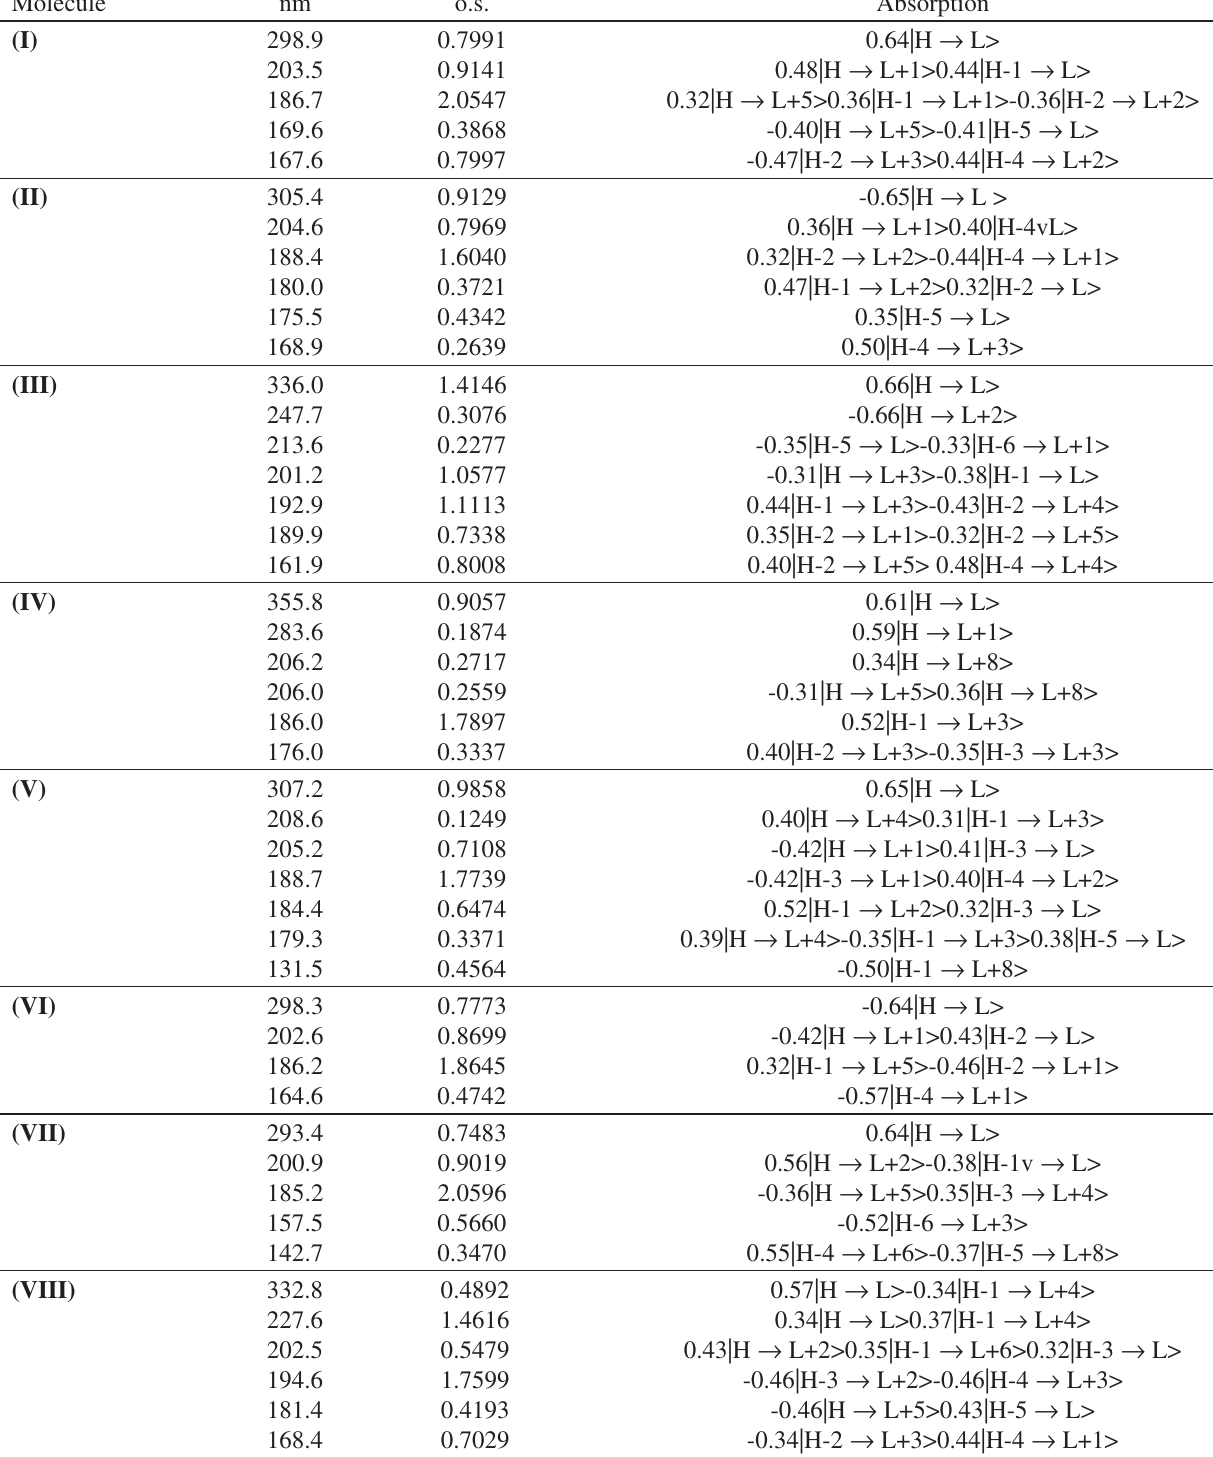
Table 2. Principal electronic UV-NIS-Vis absorption transitions as determined from INDO/S-CI calculations based on optimized ground- state geometry by PM3 for molecules I to VIII. (l/nm and o.s. represent the wavelength and the oscillator strength of the transition,